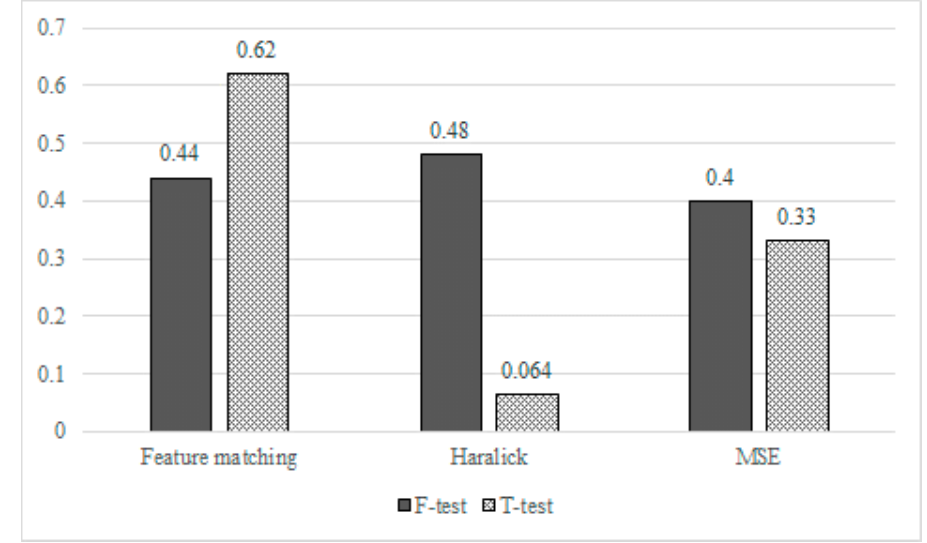
Figure 16. Statistical analysis for high-quality retinal and synthetic vessel images.